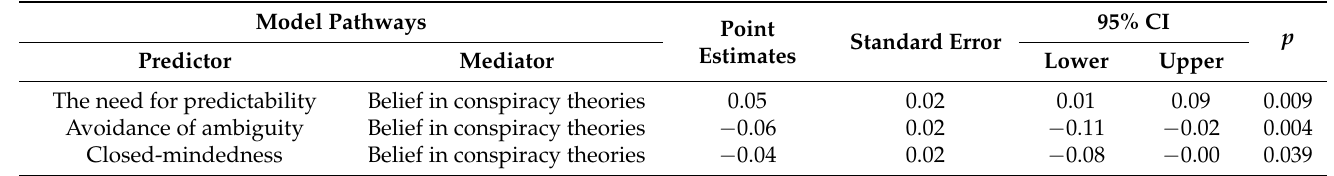
Table 2. Standardized indirect effects with bootstrap (5000 samples) 95% confidence intervals ( n = 380) between need for closure dimensions and coronavirus fear via beliefs in conspiracy theories about